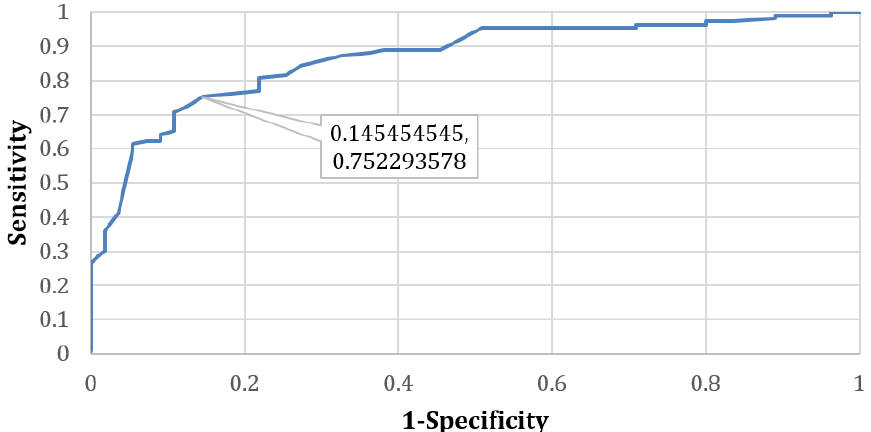
Figure 2. The ROC Figure 2. The ROC curve.